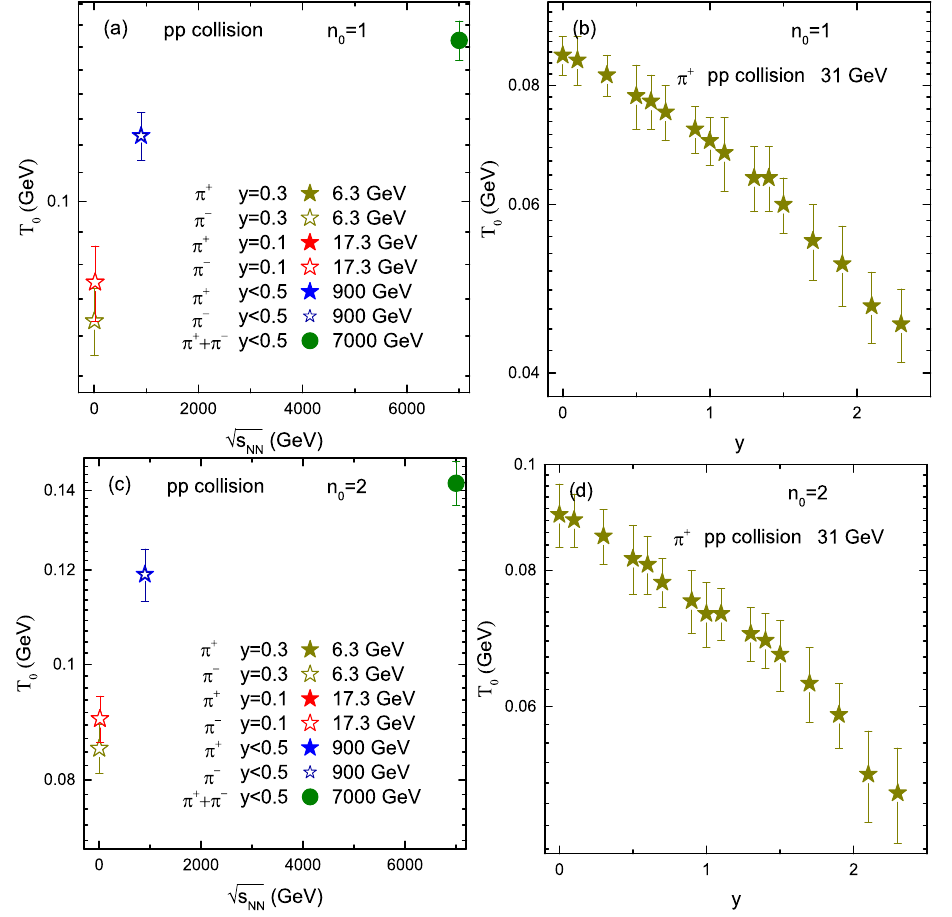
Figure 2. Kinetic freeze-out temperature as a function of collision energy as well as rapidity at 31 GeV. Panel ( a , c ) show the dependence of T 0 on the collision energy by interpreting n 0 = 1 and 2, respectively, in the TBW model, while panel ( b , d ) shows its dependence on rapidity at 31